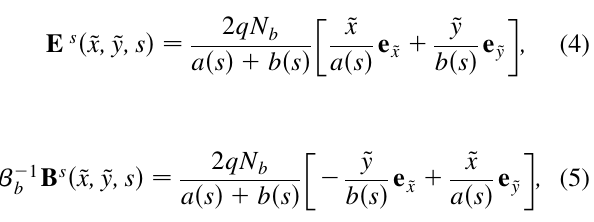
q 2 N =mc 2 (cid:10) (cid:4) , and the transverse kinetic energy of a b b